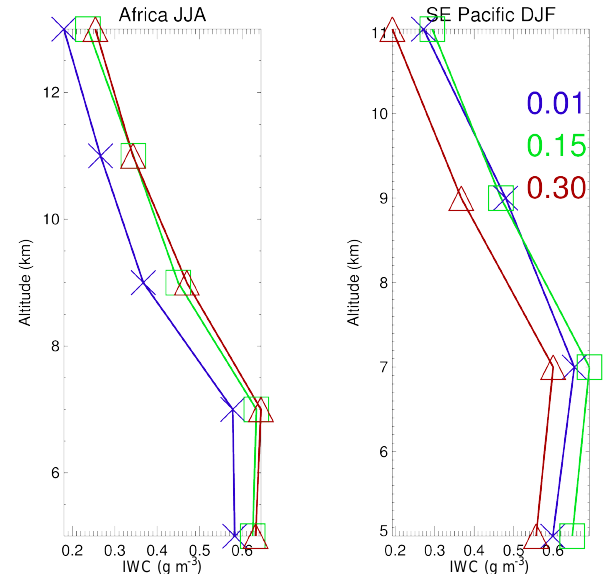
Figure 5. Average IWCreg vertical profiles over SE Pacific during August for MODIS aerosol bins with lower bin limits of 0.01, 0.15, and 0.30. Data have been averaged into 2km bins of vertical alti-